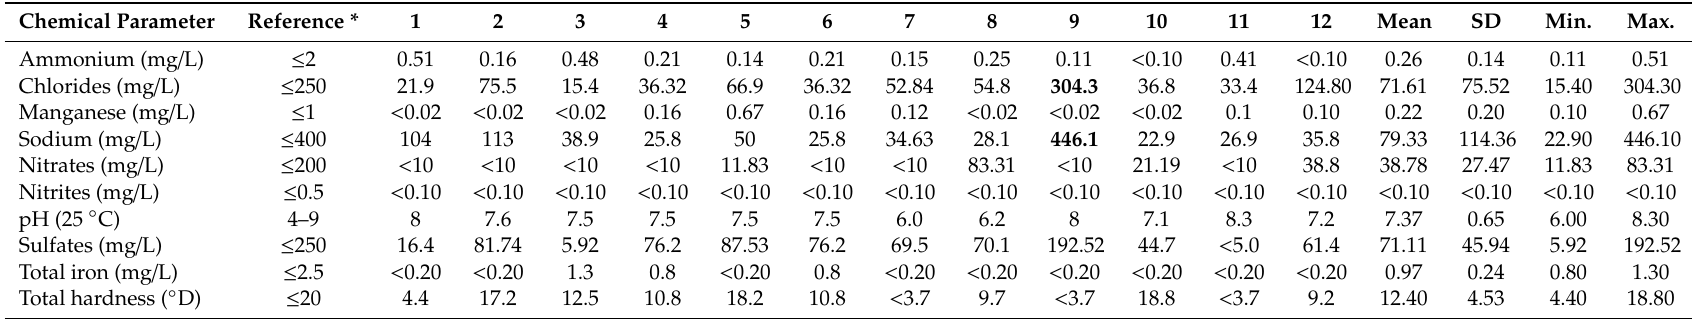
Table 3. Chemical water quality on 12 pig farms administering antimicrobial drugs via the drinking water. Bold font is used for divergent results. * The reference values were found on the website of “Diergezondheidszorg Vlaanderen” (Animal Health Care Flanders; DGZ, 2019) [13]. Chemical